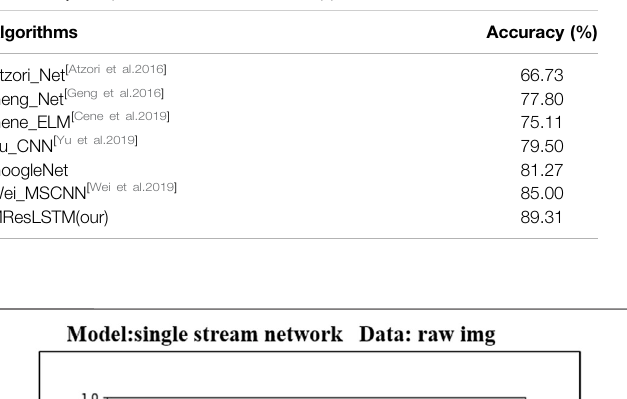
TABLE 5 | Comparison results of different approaches on NinaPro DB1.